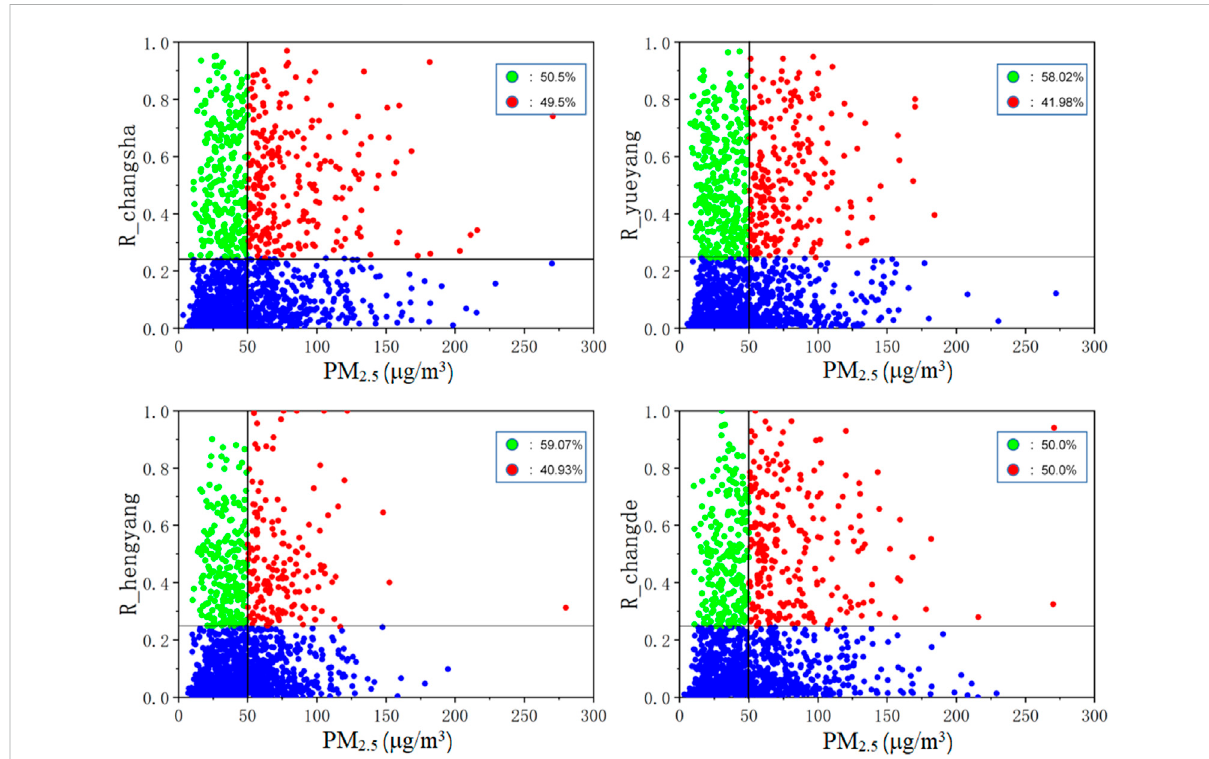
FIGURE 2 The index R as a function of the PM 2.5 concentration. The greendots indicate R > Ravg (0.245, indicated by the black lines parallel to the X -axis) and PM 2.5 concentration lower than 50 μ g/m³ (indicated by the black lines parallel to the Y -axis), the red dots indicate R > Ravg, and PM 2.5 concentration higher than 50 μ g/m³, whereas the blue dots indicate the case of no recirculation (R <